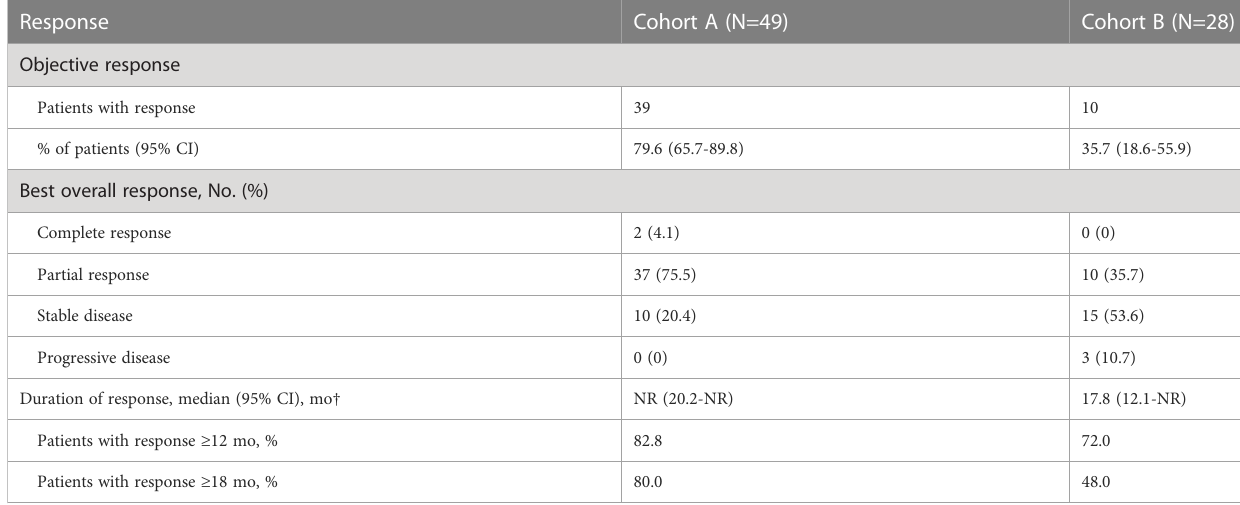
TABLE 2 Anti-tumor activity in all patients receiving